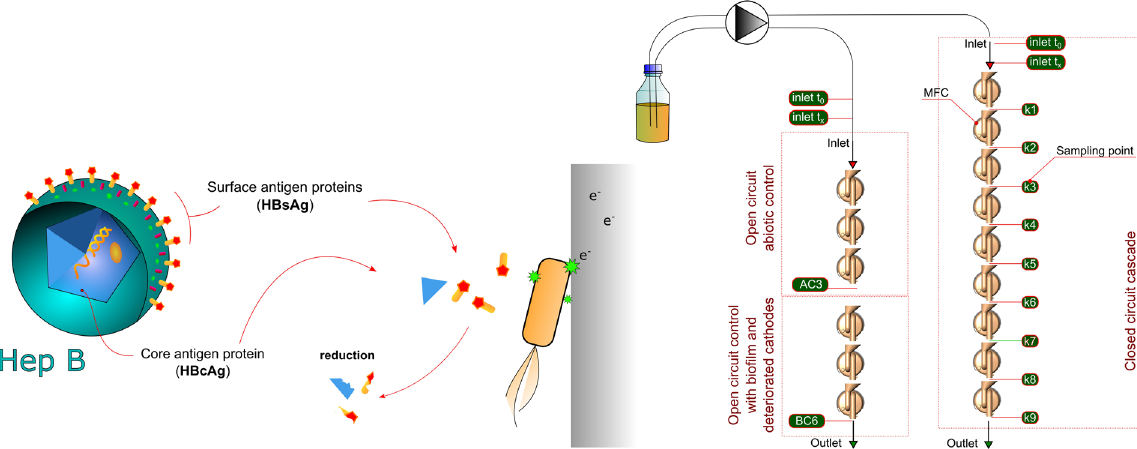
Figure 1. Schematic representation of the experimental setup and structure of Hepatitis B virus with its elements (HBcAg and HBsAg) that were deactivated in MFCs. Graphical elements of the MFC setup were derived from our previous works 26,40